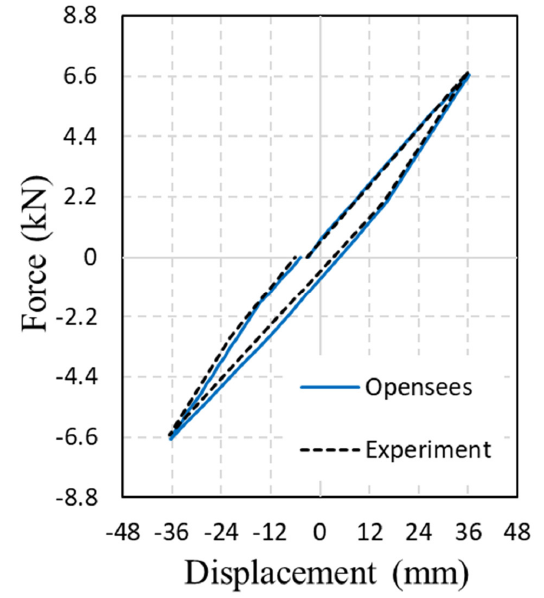
Figure 15. Numerical and experimental results (third cycle).